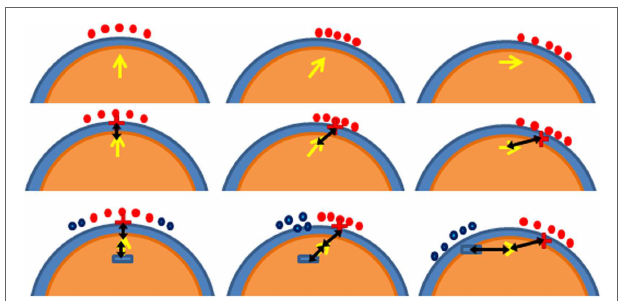
FIGURE 4 | Schematics of the ROADSS approach. The three columns represent three different targets: radial (perpendicular), oblique, and tangential to cortex orientations at position r . The first row shows the selected sources based on reciprocity (reed dots); the second row shows r m (the red “ + ” sign) and d r m r as a black arrow; and the third row shows r s (blue “–” sign) and the sinks in each case (blue dots). It is clearly seen that in the radial case (first column), the resulting pattern is similar to the “ring” approach and that in the tangential case (third column), the resulting pattern is similar to the “opposite”